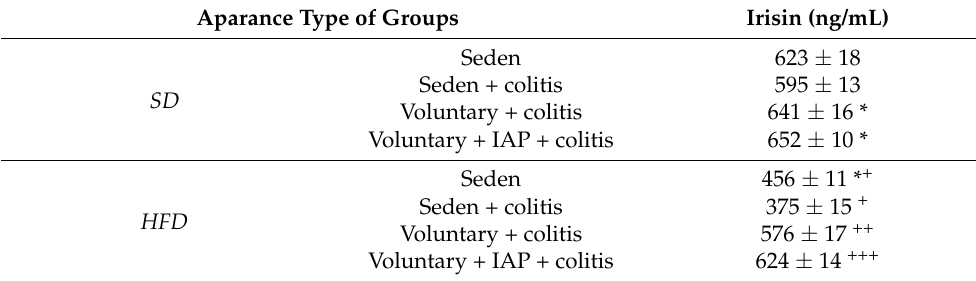
Table 1. The plasma levels of irisin in the sedentary mice (Seden) or those subjected to voluntary exercise (Voluntary) with or without TNBS colitis fed a standard diet (SD) or a high-fat diet (HFD) with or without concomitant treatment with IAP. Results are mean ± S.E.M. of six animals per experimental group. An asterisk indicates a significant change as compared to the respective values in the sedentary mice with or without colitis fed an SD ( p < 0.05). An asterisk and a cross indicate a significant change as compared to the respective values in the colitis animals fed an SD ( p < 0.05). A cross indicates a significant change as compared to the value obtained in the sedentary HFD animals with colitis ( p < 0.05). A double cross indicates a significant change as compared to the value obtained in the sedentary HFD animals with colitis ( p < 0.05). A triple cross indicates a significant change as compared to the value obtained in the exercising HFD animals with colitis ( p <